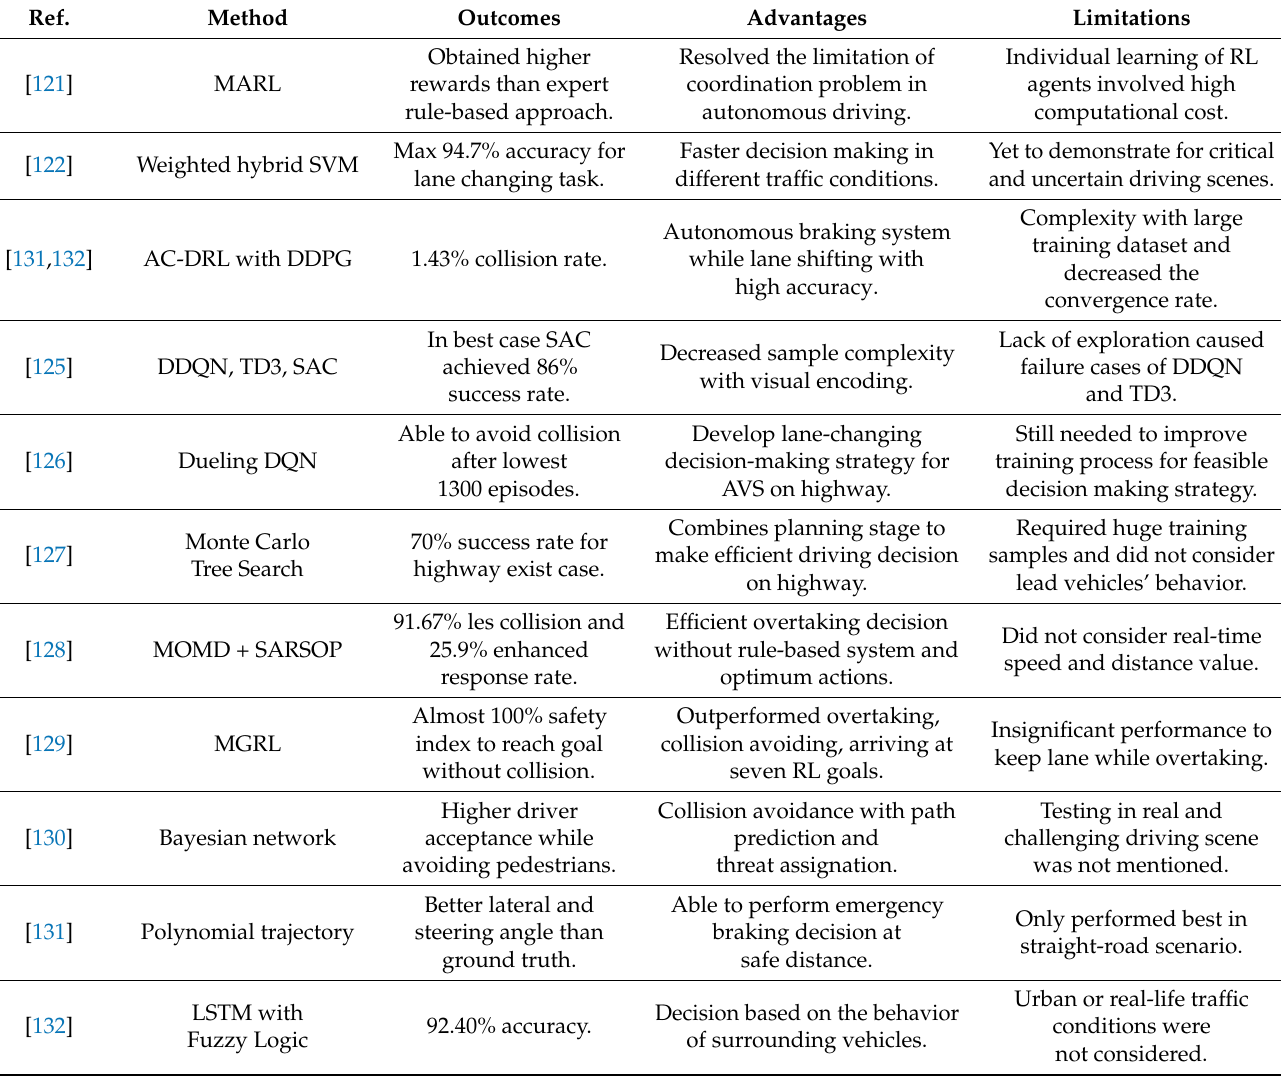
Table 10. Summary of multiple deep learning methods for decision-making process.